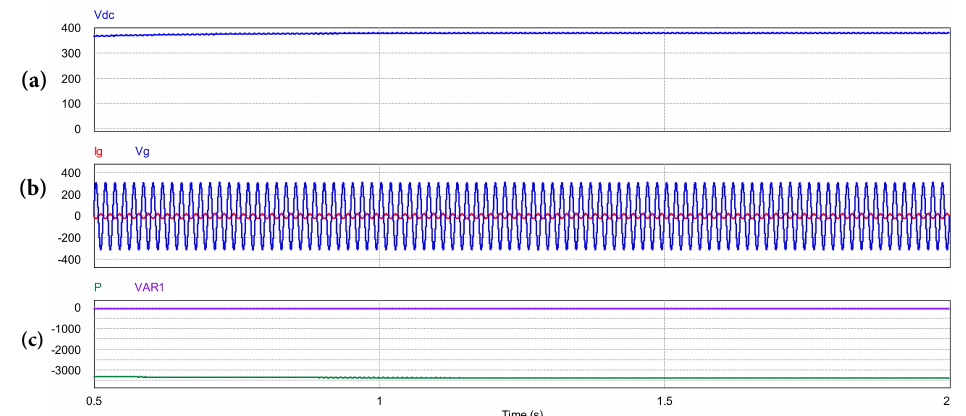
Figure 24. 3.3 kW DC-AC single phase full bridge converter, closed loop performing in rectifier mode. ( a ) DC bus voltage, ( b ) grid current (red) and grid voltage (blue) , ( c ) active (green) and reactive (purple) power.